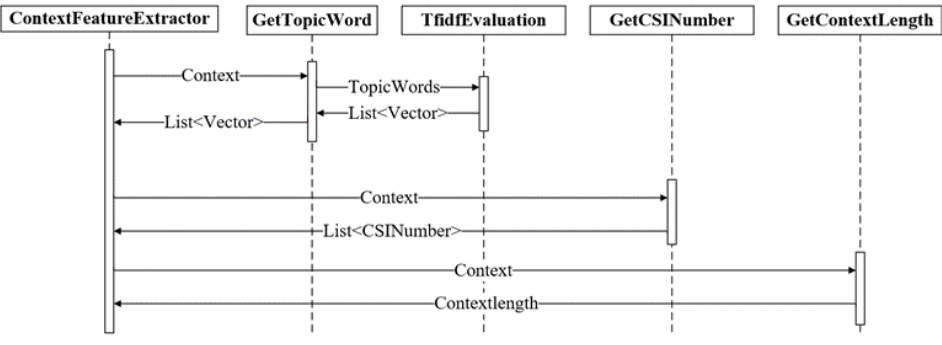
Figure 5. Specific feature extraction sequence diagram.